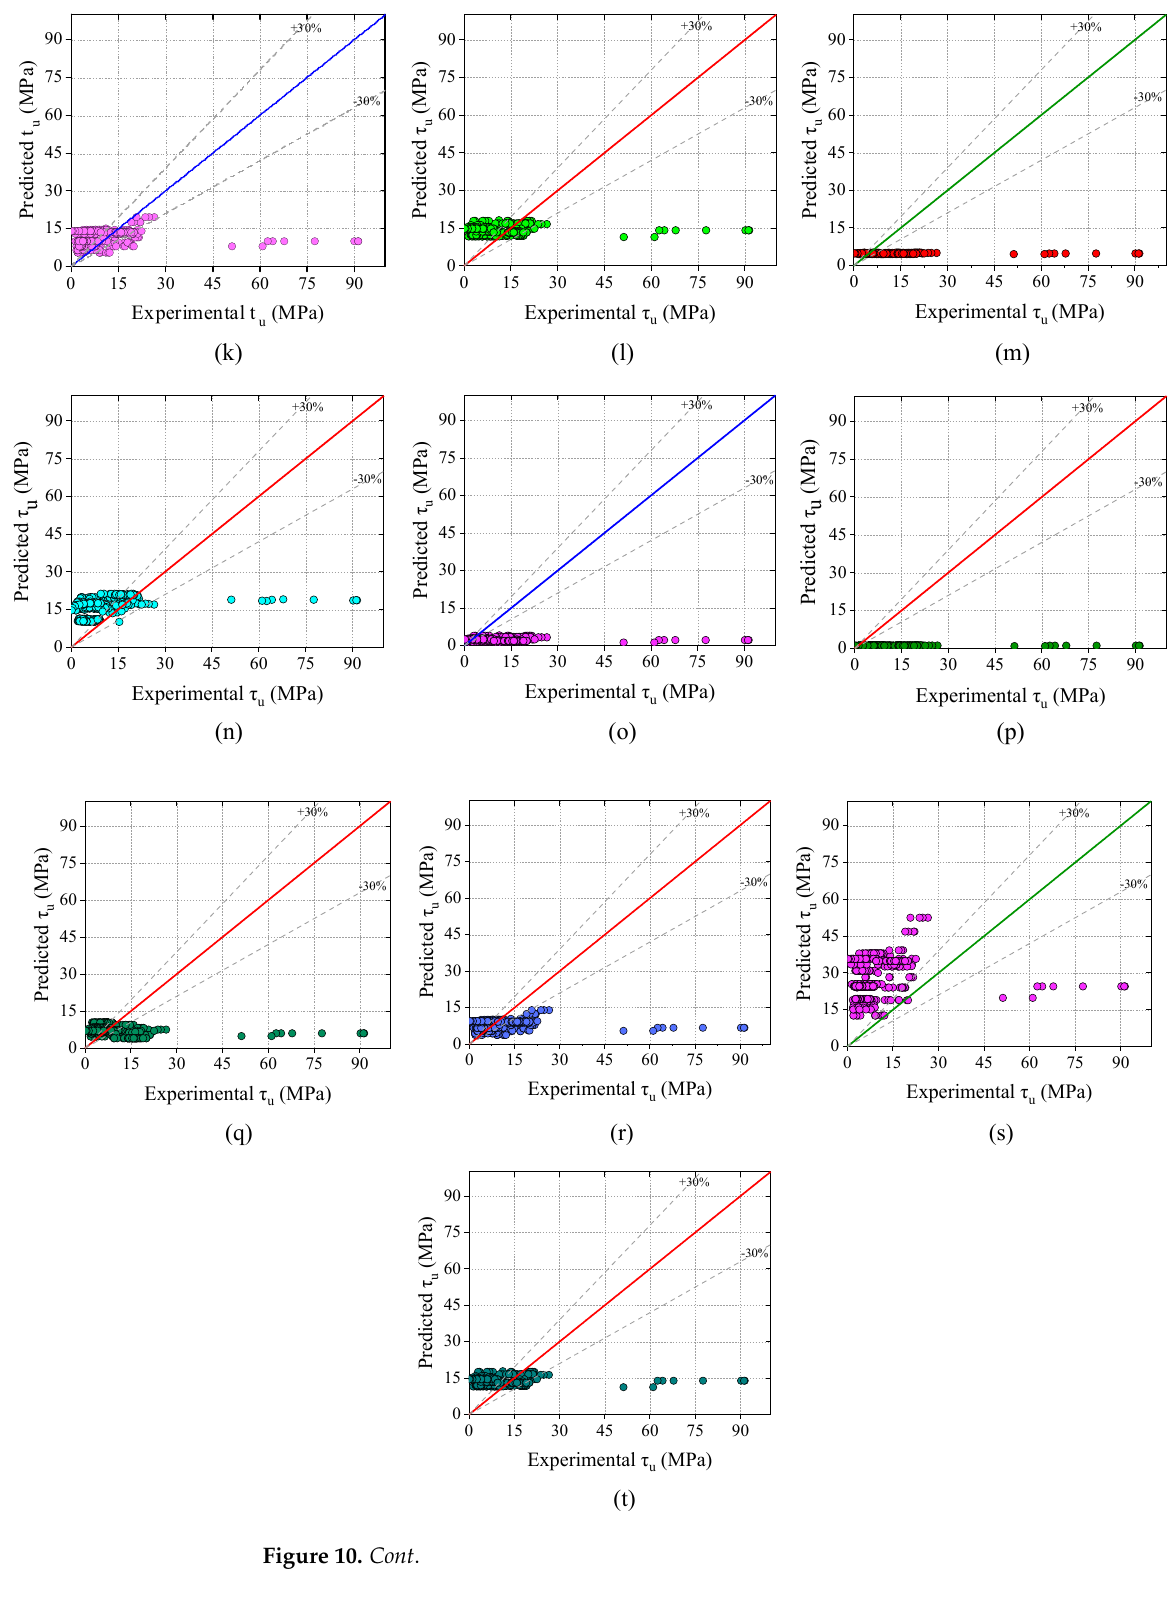
Figure 10. Experimental vs. predicted values of testing samples; ( a ) Model-1, ( b ) Model-2, ( c ) Model- Figure 10. Cont 3, ( d ) Model-4, ( e ) Model-5, ( f ) Model-6, ( g ) Model-7, ( h ) Model-8, ( i ) Model-9, ( j ) Model-10, ( k ) Model-11, ( l ) Model-12, ( m ) Model-13, ( n ) Model-14, ( o ) Model-15, ( p ) Model-16, ( q ) Model-17, ( r ) Model-18, ( s ) Model-19, ( t ) Model-20.